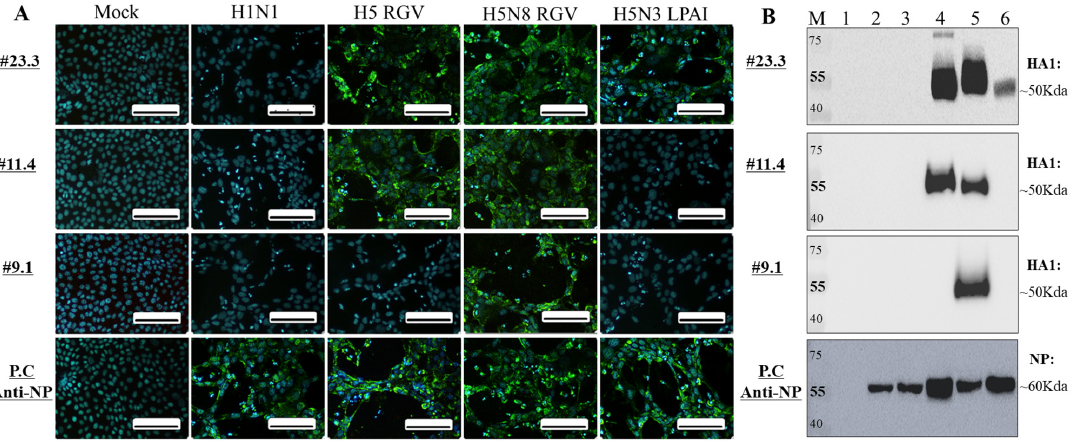
Figure 3. Characterization of H5-specific mAbs by immunoassay. ( A ) Immunofluorescence assay (IFA). Cells were coated and fixed on a coverslip using 4% paraformaldehyde, infected for 12 h with H1 and H5 subtypes at multiplicity of infection (MOI) = 0.5, and then incubated with the mAb candidates #23.3, #11.4, and #9.1. After washing, fluorescence was detected by a FITC-conjugated secondary antibody. Scale bar, 100 µ m. Original magnification, 400 × . Mock, no virus infection. ( B ) Western blot assay; 500 HAU of each virus was loaded per lane and 10% SDS-PAGE was performed for 2 h. The proteins were then transferred onto a polyvinylidene difluoride (PVDF) membrane for 3 h. After 5% non-fat milk blocking, the membrane was incubated with primary mAb candidates and then with the secondary antibody HRP. M, marker; 1, BSA; 2, H1N1; 3, H9N2; 4, H5/2.3.4.4b RGV; 5, H5N8/2.3.4.4c RGV; 6, H5N3 LPAI. The positive control (P.C) is the anti-NP of influenza A